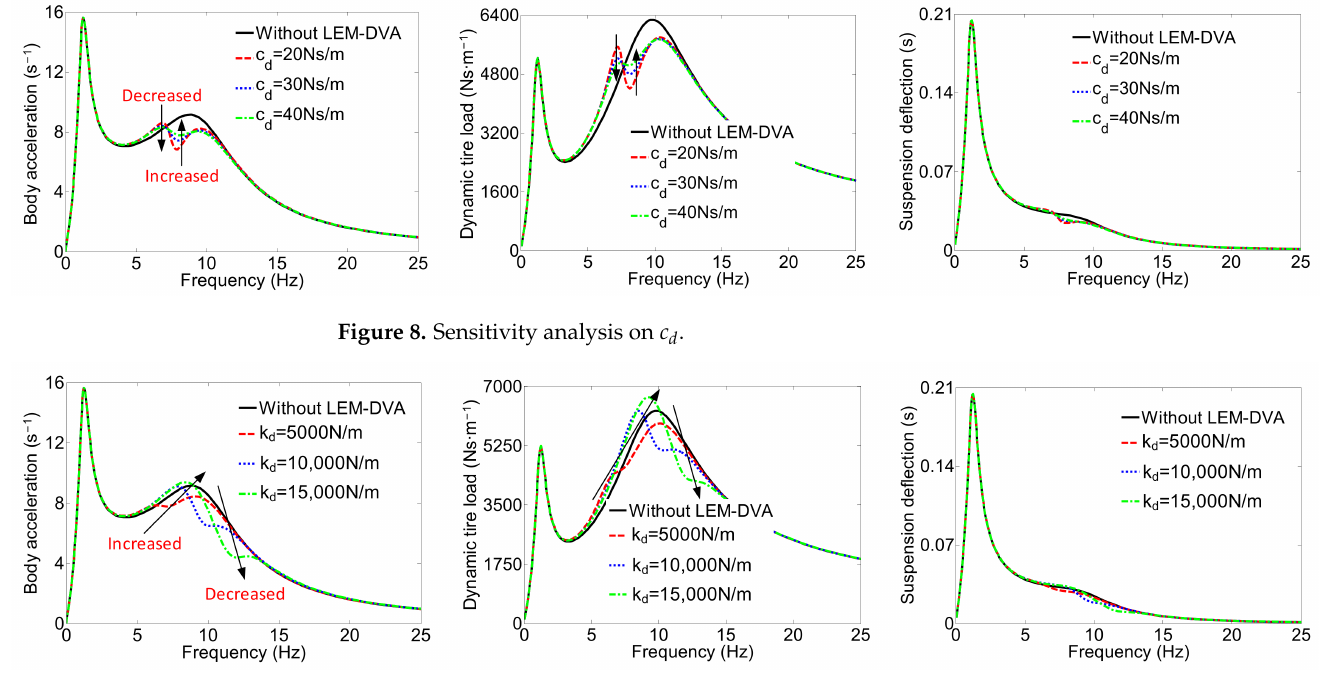
Figure 9. Sensitivity analysis on k d